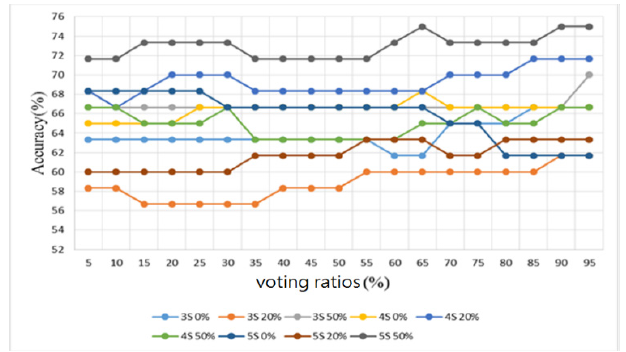
Figure 20. Lung sound classification results: Accuracy.